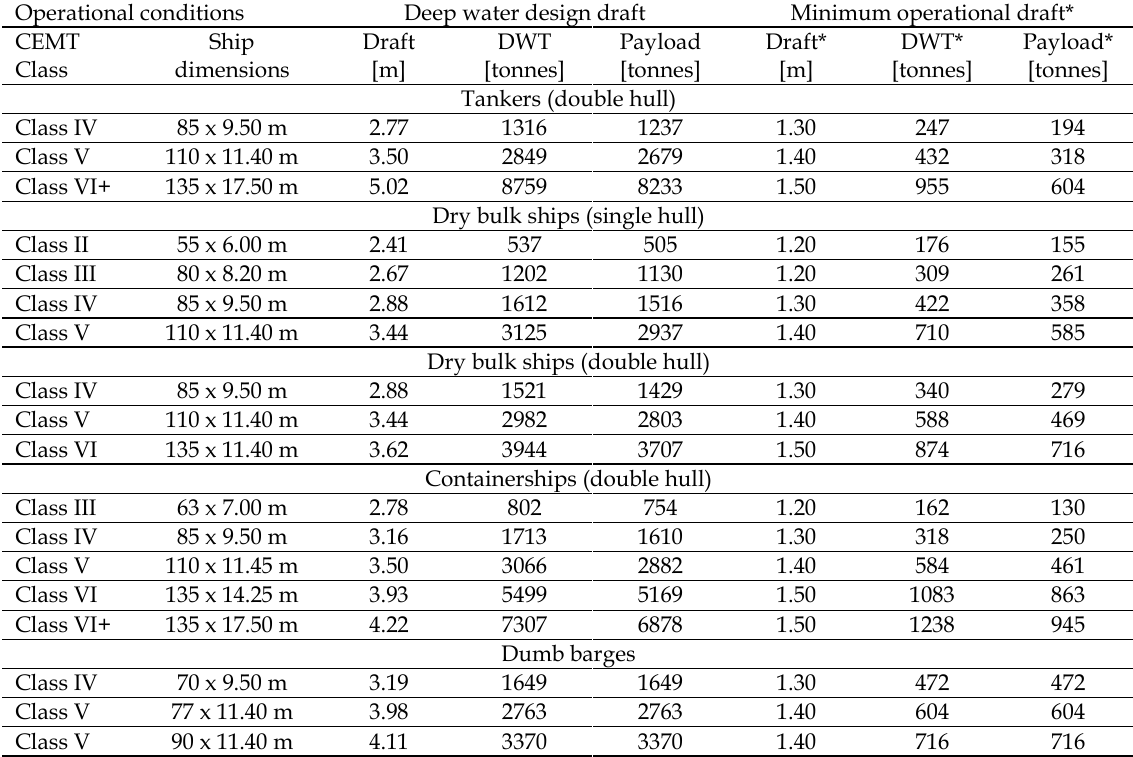
Table 7. Effect of low water on deadweight and payload capacity of inland ships Operational